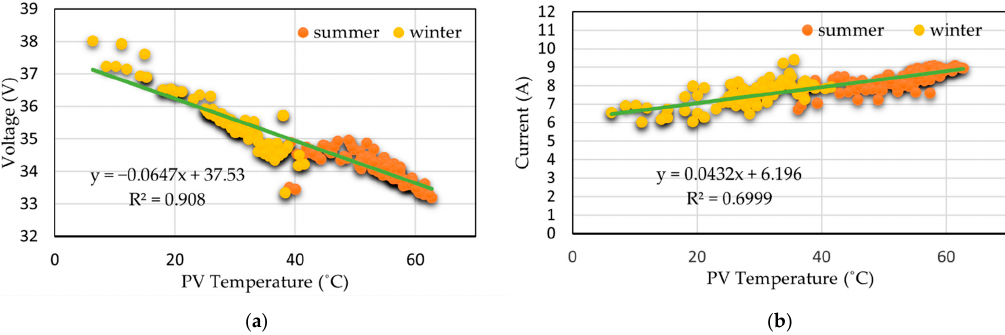
Figure 10. Relation between PV ( a ) voltage-PV temperature and ( b ) current-PV temperature.